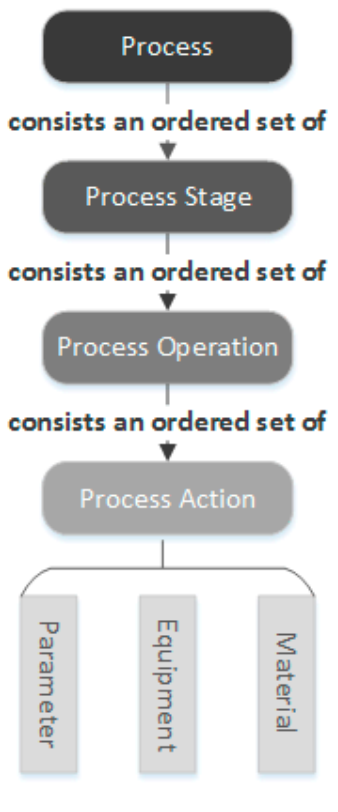
Figure 2. ISA-88 process model.